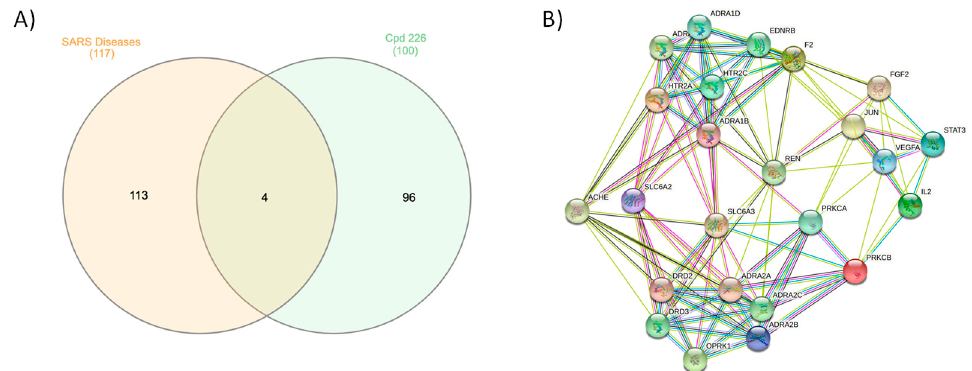
Figure 8. ( A ) Venn diagram analysis for erylosides B (226) with SARS disease genes and ( B ) STRING PPI network for the top targets identified by network analyzer for erylosides B (226) as a M pro inhibitor.